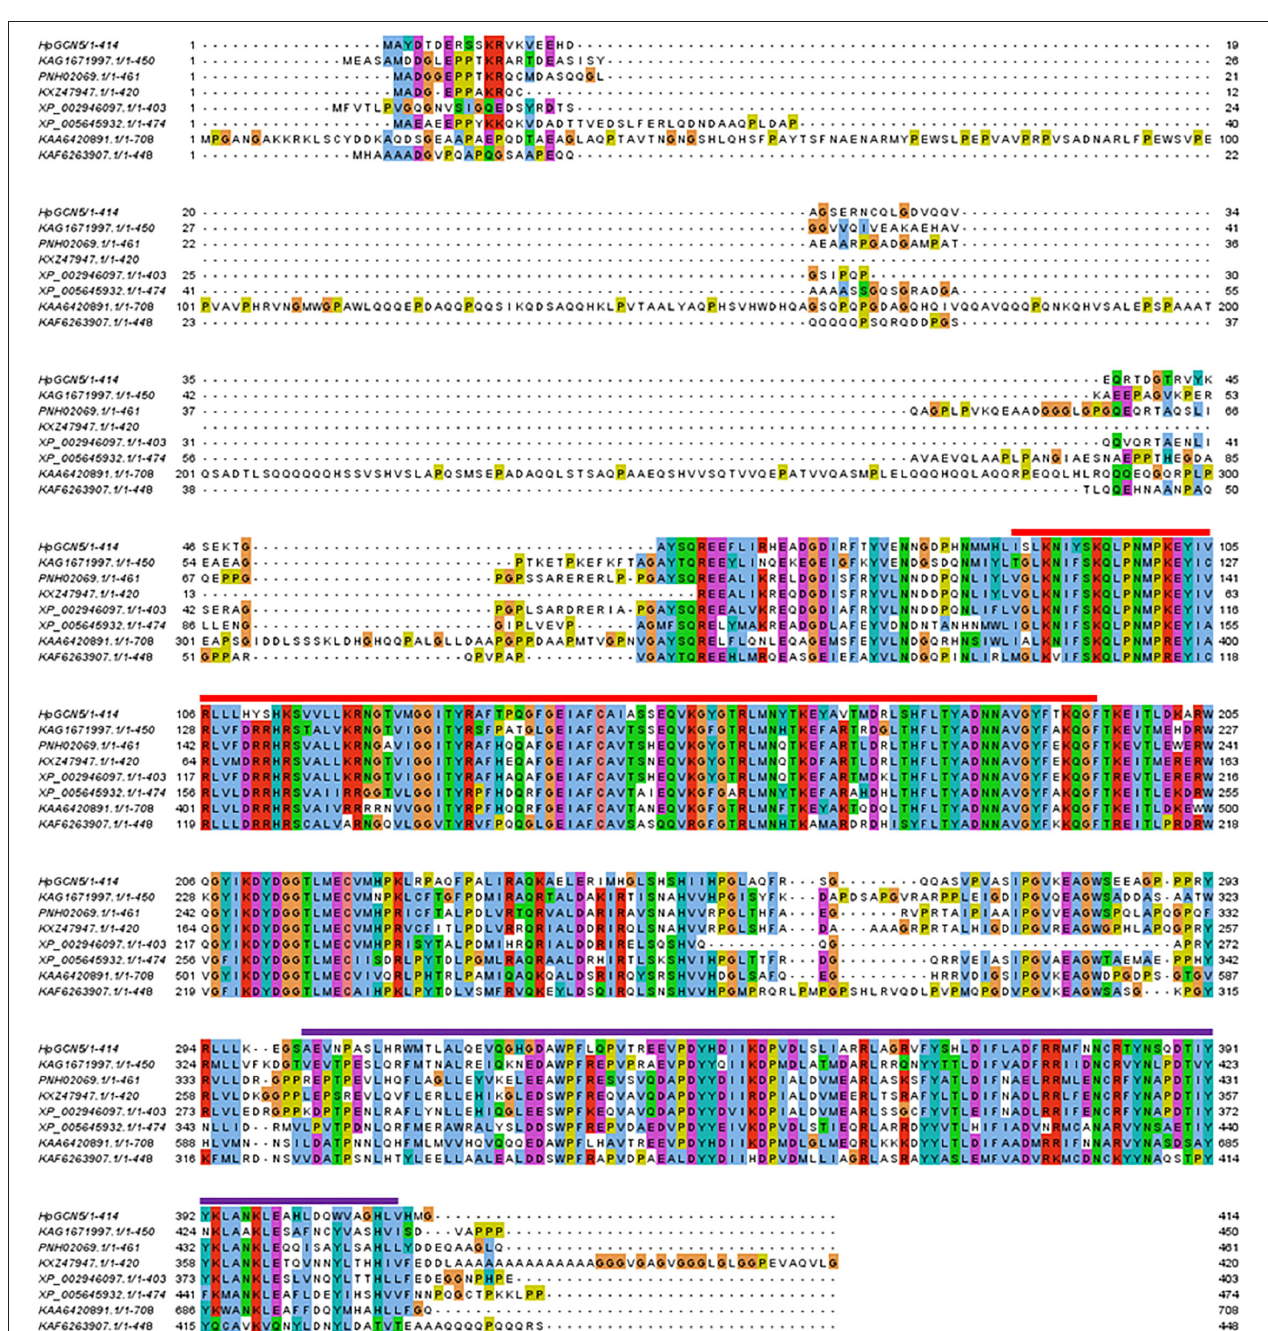
FIGURE 2 | The alignment of amino acids of GCN5 gene from Haematococcus pluvialis and its homologous from other species including KAG1671997.1 from Chlamydomonas sp. , PNH02069.1 from Tetrabaena socialis , KXZ47947.1 from Gonium pectoral , XP002946097.1 from Volvox carteri , XP 005645932.1 from Coccomyxa subellipsoidea , KAA6420891.1 from Trebouxia sp. , and KAF6263907.1 from Scenedesmus sp. The Acetyltransf_1 domain (Pfam accession: PF00583) was shown by the red line and the BROMO domain (Pfam accession: PF00439) was shown by the purple line.